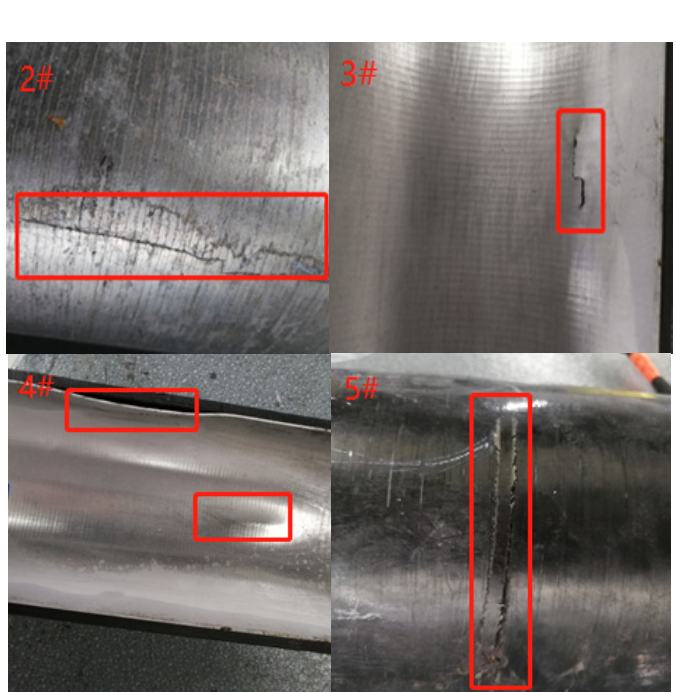
Figure 9. Fatigue failure location and mode of COPVs 2#–5#.